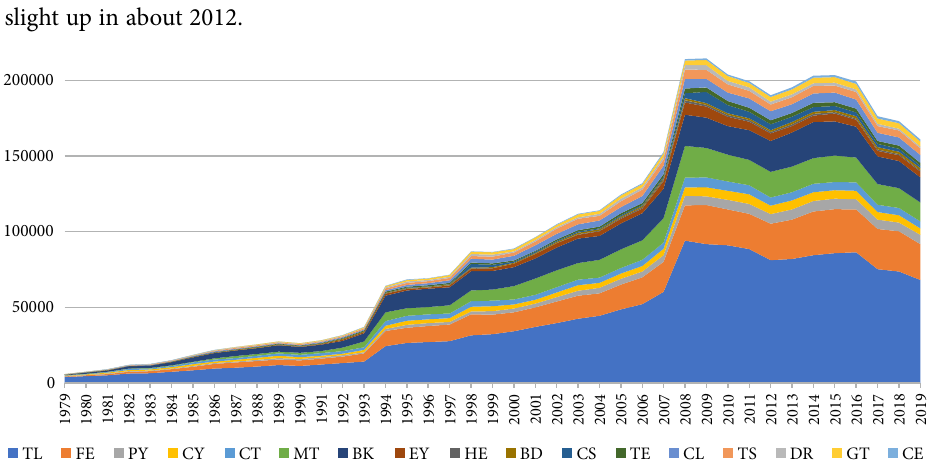
Figure 2. The trend ratio of literature variables from 1979 to 2019 (source: authors’